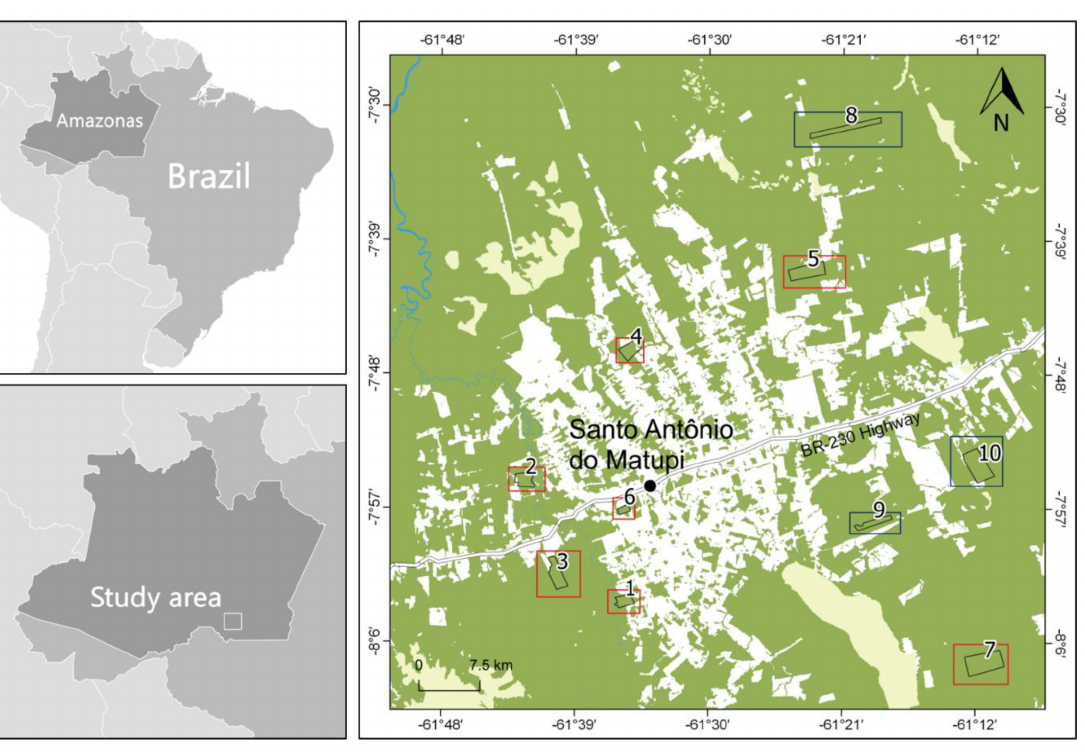
Figure 1. Location of the study area, the study sites (in red: Selectively logged areas, in blue: Unlogged areas) and the sustainable forest management areas (black polygons, numbered from 1 to 10). Background map (year 2017): Deforestation (white), non-forest vegetation (yellow), and forests